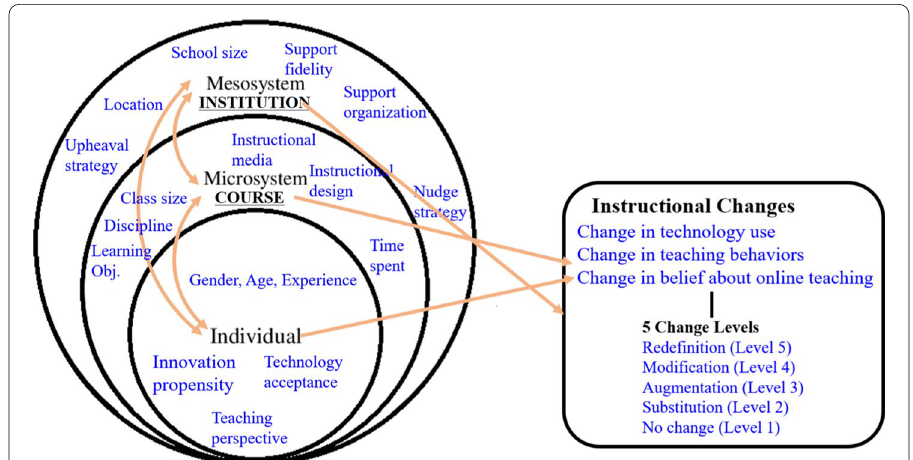
Fig. 1 Theoretical framework of the